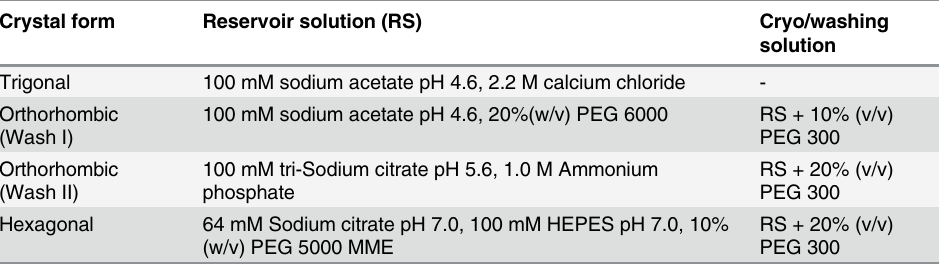
Table 1. Crystallization conditions and cryo protection / washing procedure. Crystal